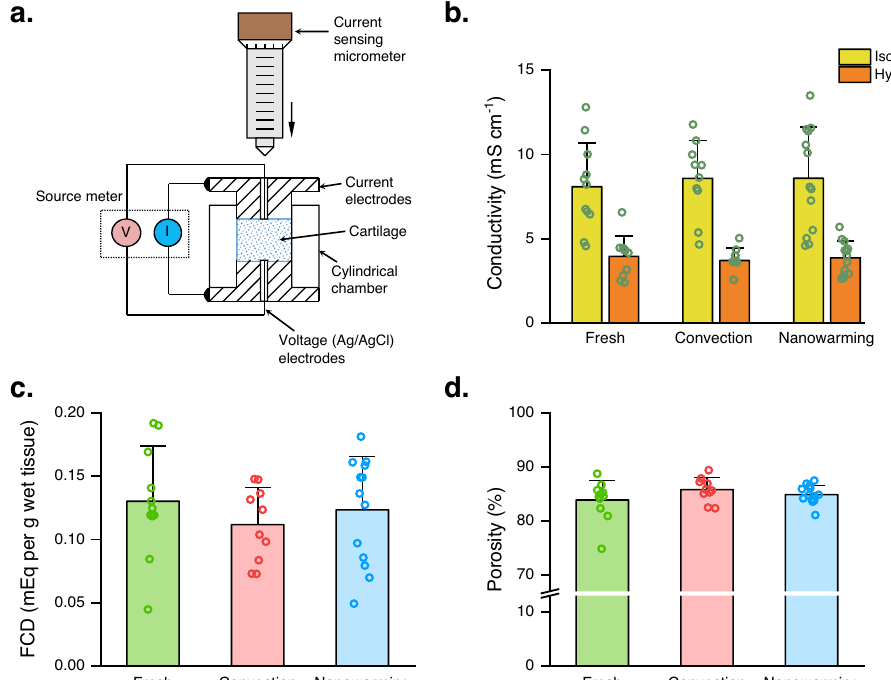
Fig. 3 Nanowarmed cartilage is more alike fresh cartilage regarding cartilage electrical and compositional properties. a Schematic of electrical conductivity measurement. Cartilage electrical conductivity and FCD were determined with a customized conductivity apparatus consisting of a current sensing micrometer for cartilage thickness measurement, two current electrodes, two Ag/AgCl voltage electrodes, and a cylindrical chamber. b Electrical conductivity of fresh ( n = 11 independent samples), convection ( n = 10 independent samples), and nanowarming ( n = 13 independent samples) cartilage measured under both isotonic and hypotonic conditions. c FCD of fresh ( n = 11 independent samples), convection ( n = 10 independent samples), and nanowarming ( n = 13 independent samples) cartilage. d Porosity of fresh ( n = 11 independent samples), convection ( n = 10 independent samples), and nanowarming ( n = 13 independent samples) cartilage. All data depict mean ± standard deviation. Note: mIONPs in the nanowaming group are loaded through the immersion approach for all data presented